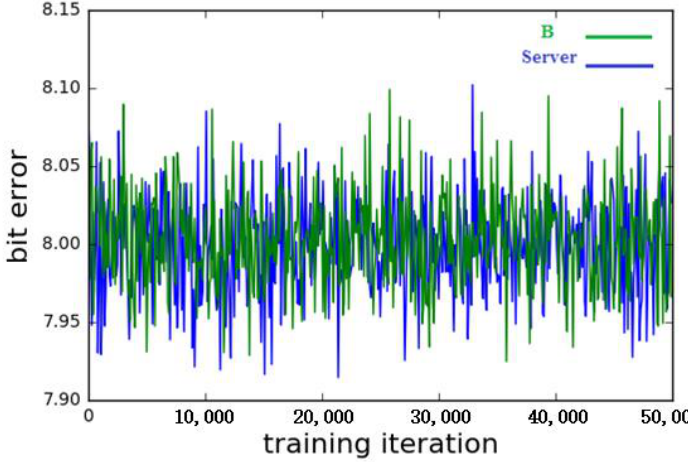
Figure 9. The initial failure of the training process.